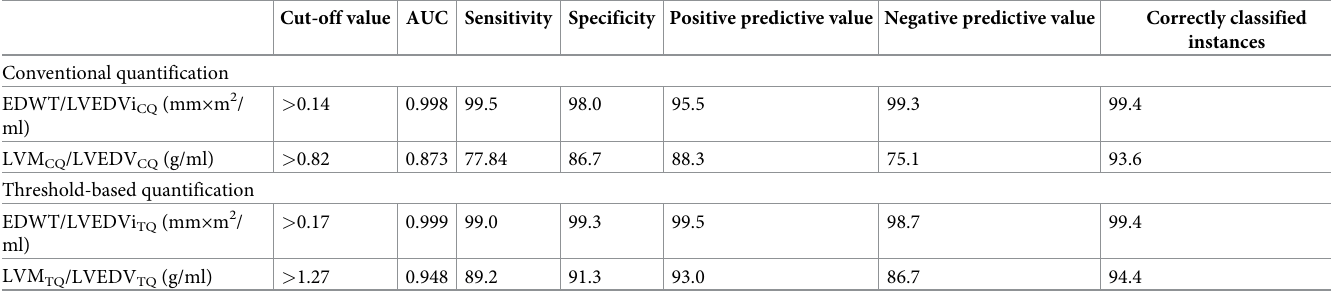
Table 3. Cut-off values for optimised sensitivity and specificity. Cut-off value AUC Sensitivity Specificity Positive predictive value Negative predictive